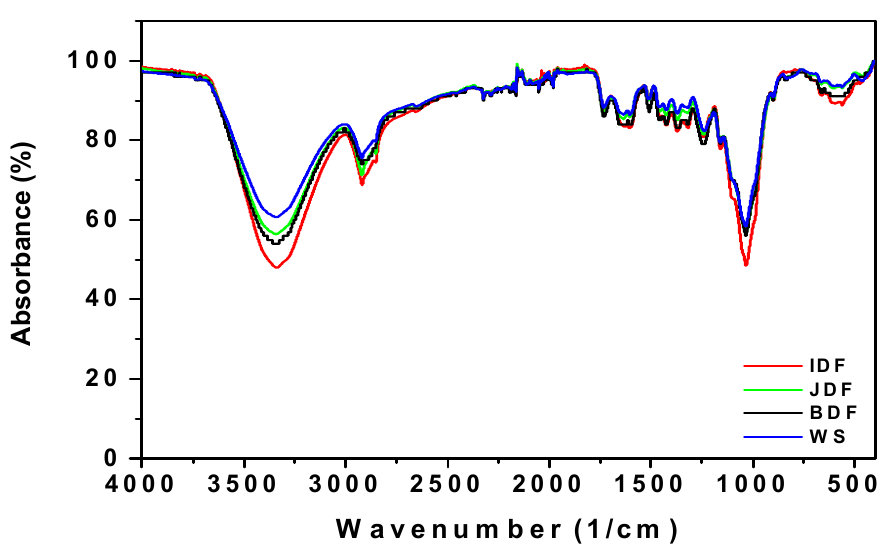
Figure 7. Fourier transform infrared spectroscopy (FTIR) spectra of IDF, JDF, BDF and WS.